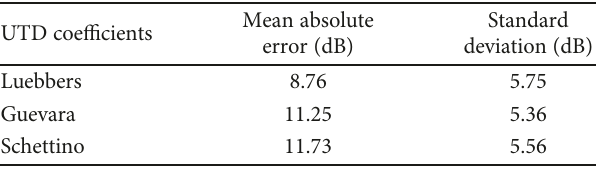
Table 6: Statistics of the path loss for Cali City.